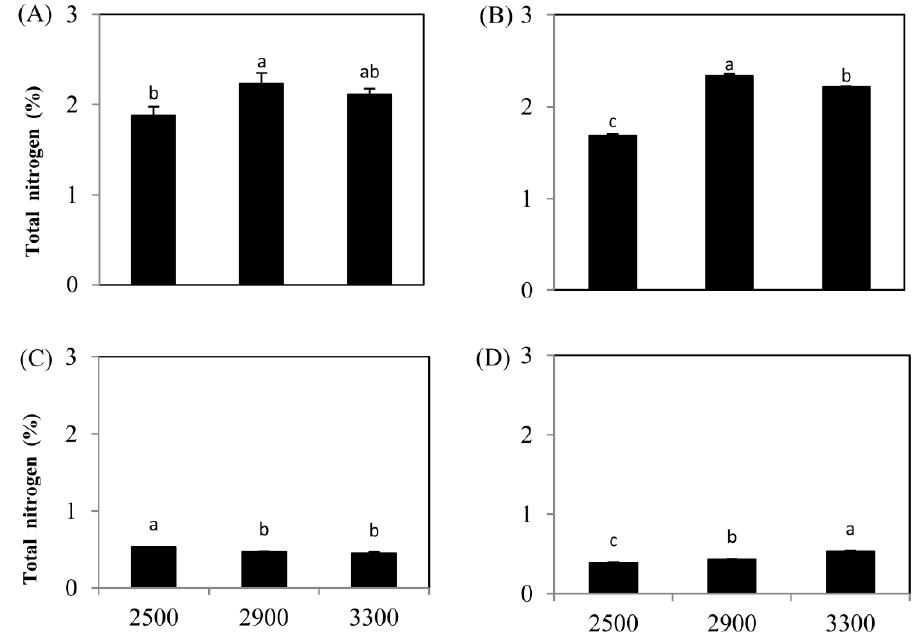
Figure 3. Changes of total N in the different tissues of Picea crassifolia with the increasing elevations (m). ( A ) Current-year needles, ( B ) current-year branches, ( C ) coarse roots with 0.5–1.0 cm in diameter, ( D ) fine roots with <0.5 cm in diameter. Different lowercase letters represented the significance levels ( p < 0.05) among the different elevations.